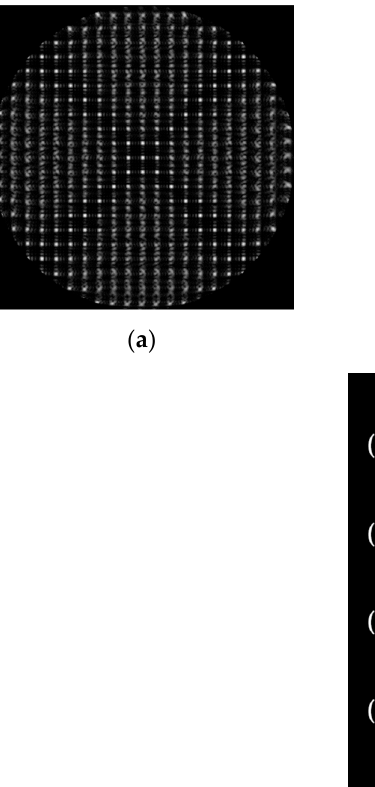
( , ) Z r ϕ ( n = 2, 4, 6, 8, 10) with various levels ,2 n